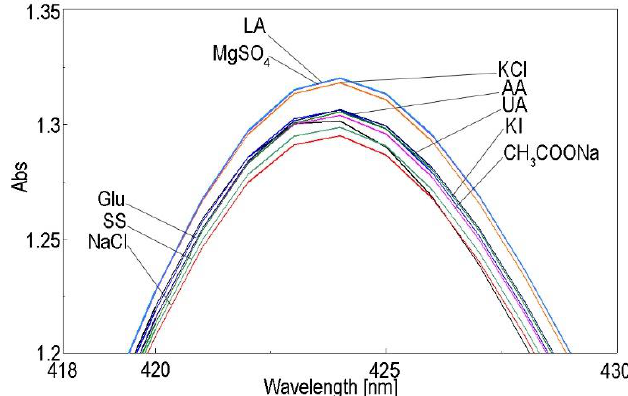
Figure 22. Superposed UV-Vis spectra representing the influence of the following interfering species: glucose (Glu), ascorbic acid (AA), NaCl, KCl, CH 3 COONa, MgSO 4 , KI, lactic acid (LA), and sodium salicylate (SS) on the TAmPP-PtNPs hybrid complex at concentrations 1000-fold higher than UA.